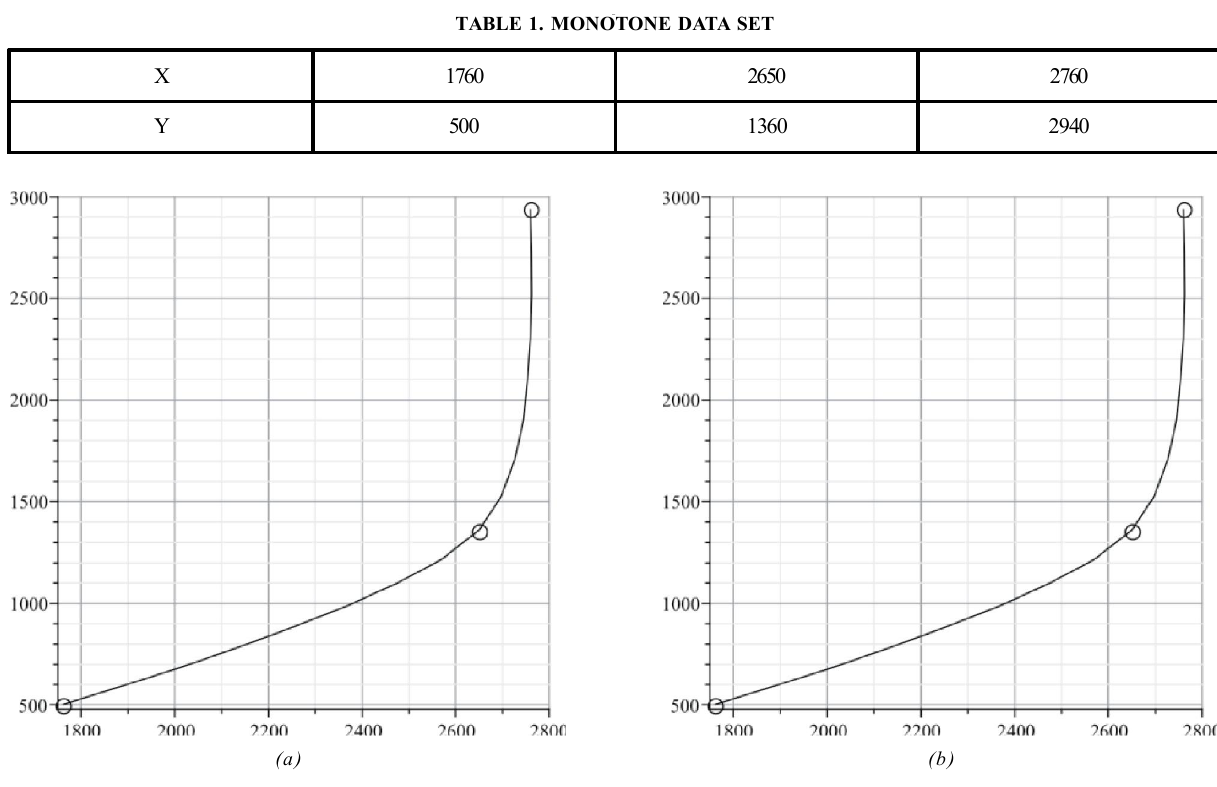
TABLE 1. MONOTONE DATA SET